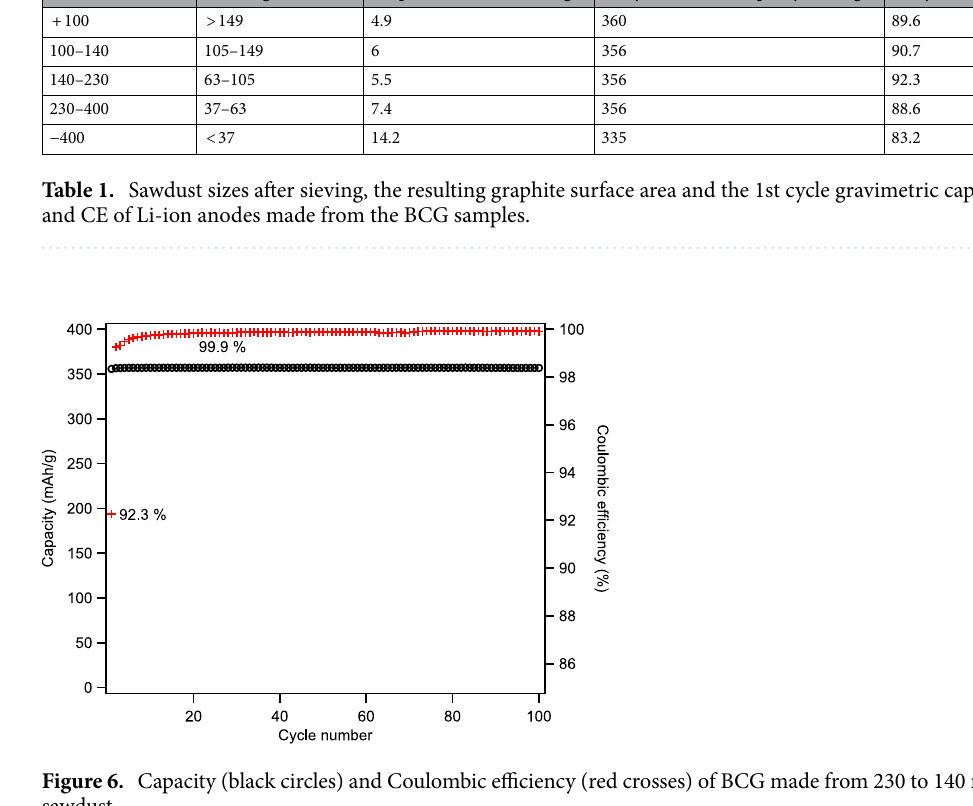
Sieve size (mesh)